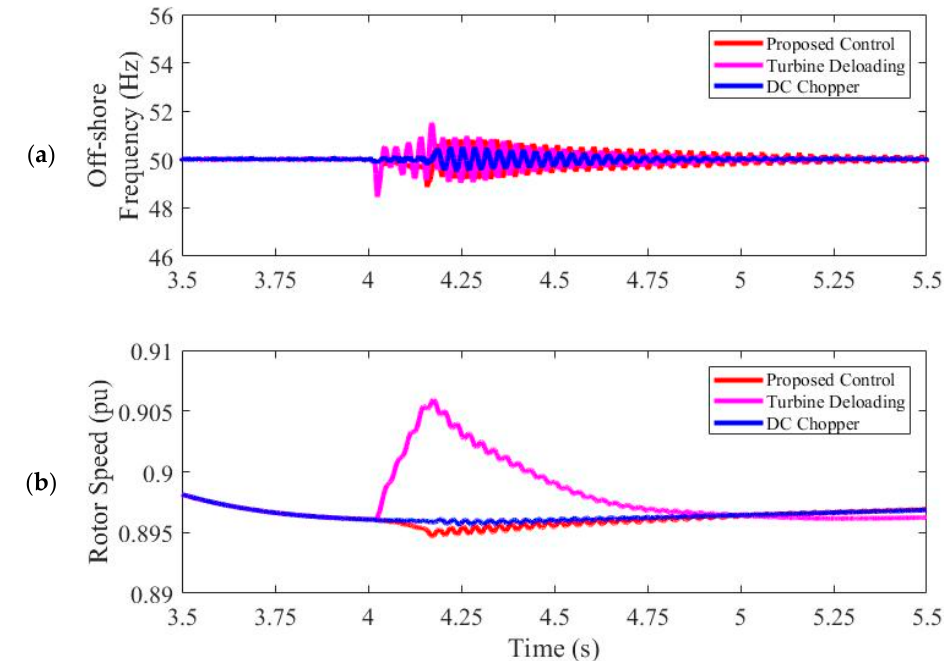
Figure 17. Simulation results of the on-shore fault scenario with a 2.95 Ω fault resistance . ( a ) Off-shore frequency for each simulation case. ( b ) DFIG rotor turbine acceleration for each simulation case. ( c ) Comparison of DFIG rotor turbine speed by the participation coefficient.